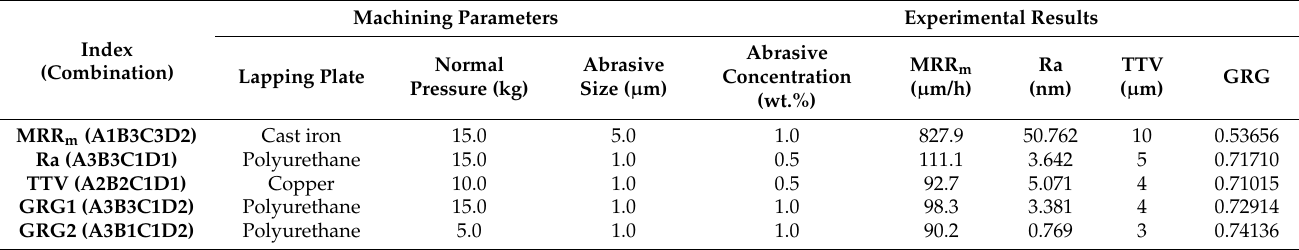
Table 14. Experimental protocol and results of the confirmation